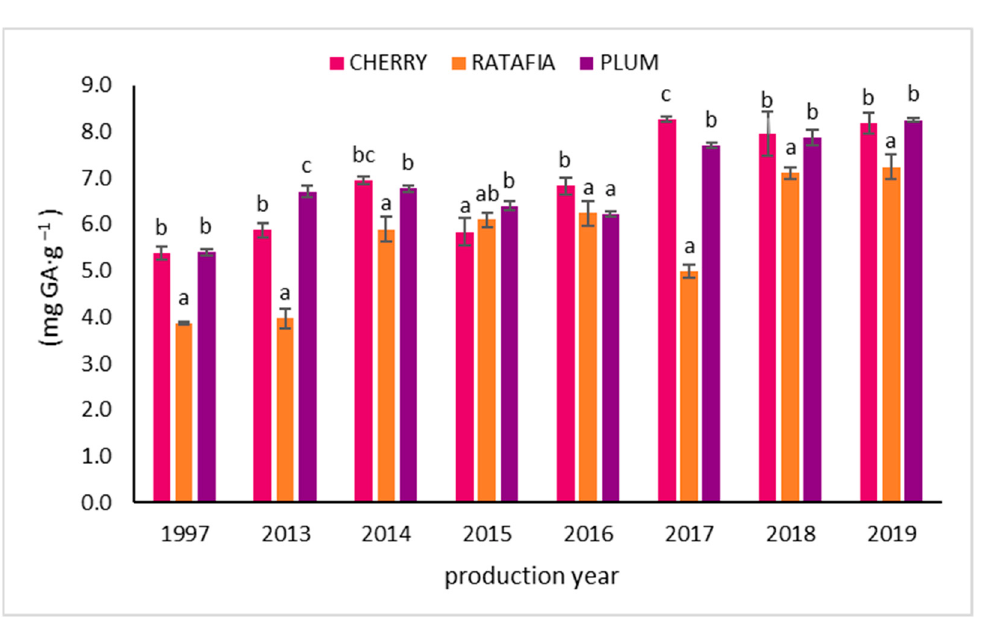
Figure 5. The anthocyanin content of nalewkas (Mean ± SD, n = 3). Different letters indicate signifi- cant differences between the nalewkas in individual years of production ( α = 0.05). The result was expressed in mg Cy-3-Glu·mL − 1 of nalewka; Cy-3-Glu—cyjanidin-3-glucoside.